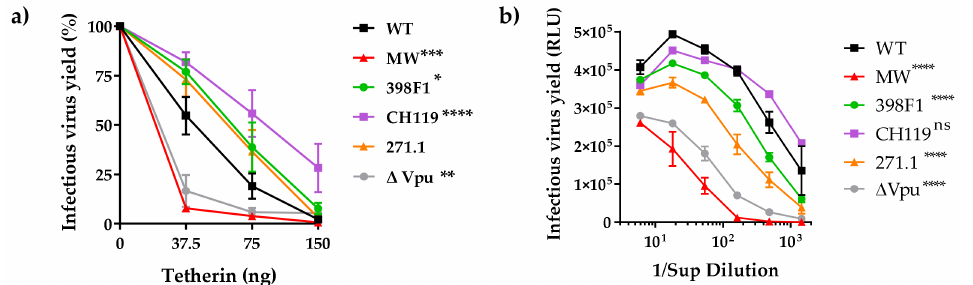
Figure 3. Effect of Vpu swaps on virus release in presence of tetherin. ( a ) Virus release from 293T cells following co-transfection with IMCs in presence of various amounts of plasmid expressing human tetherin. Release of infectious virus was determined by infection of TZM-bl indicator cells and is shown as percentage of the release efficiency in the absence of tetherin, set at 100%. Infections were performed in triplicate and mean and SEM from three experiments are shown *, p = 0.03; **, p = 0.002; ***, p = 0.0002; ****, p < 0.0001 by two-way ANOVA vs. WT. ( b ) Virus release from TZM.bl cells, expressing endogenous tetherin, following transfection with proviral IMC bearing the chimeric Vpu and Env. Virus release was assessed by infecting TZM.bl cells with the supernatant from each transfection. Mean +SEM from representative experiment performed in duplicate are shown. ****, p < 0.0001 by two-way